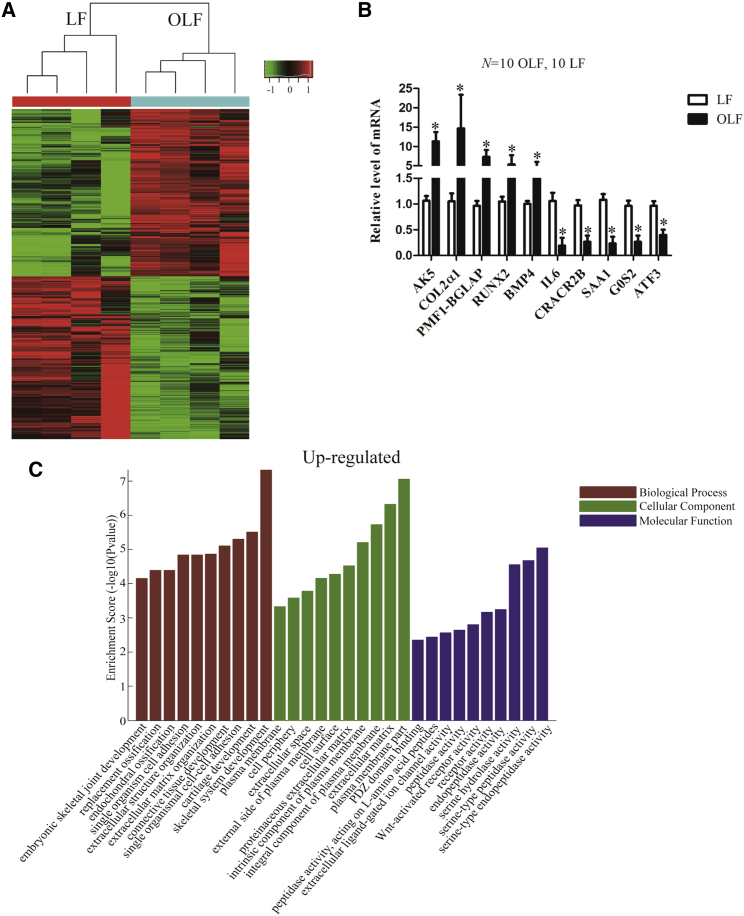
Expression Profile of mRNAs in OLF and Normal LF(A) Microarray analysis for mRNA was performed with RNA extracted from ossified (n = 4) and normal (n = 4) ligamentum flavum. Hierarchical cluster analysis of significantly differentially expressed mRNAs: bright green, under-expression; gray, no change; bright red, overexpression. (B) Ten differentially expressed representative mRNAs were validated in OLF and normal LF tissues by qPCR (n = 10 per group). GAPDH was used as an internal control. (C) GO annotation of the linear counterparts of upregulated mRNAs with the top ten enrichment scores covering domains of biological processes, CCs, and MFs was performed. Data are presented as mean ± SEM; p values were analyzed by Student’s t test; *p < 0.05.